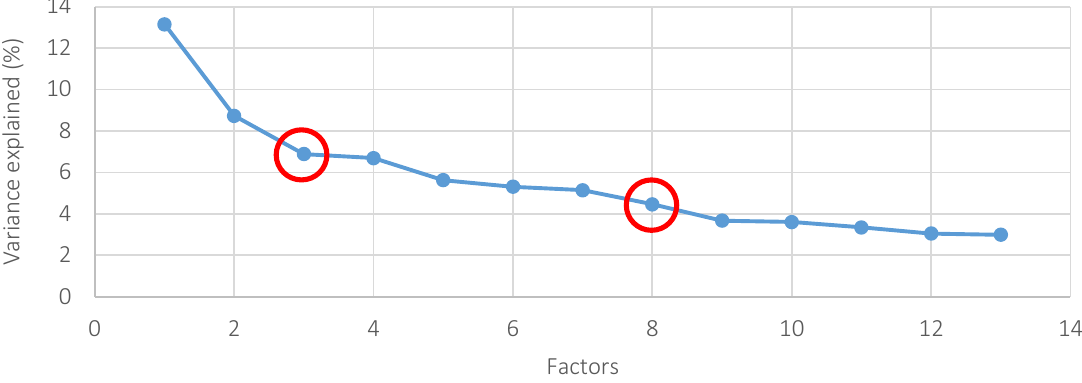
Figure 2. Point of